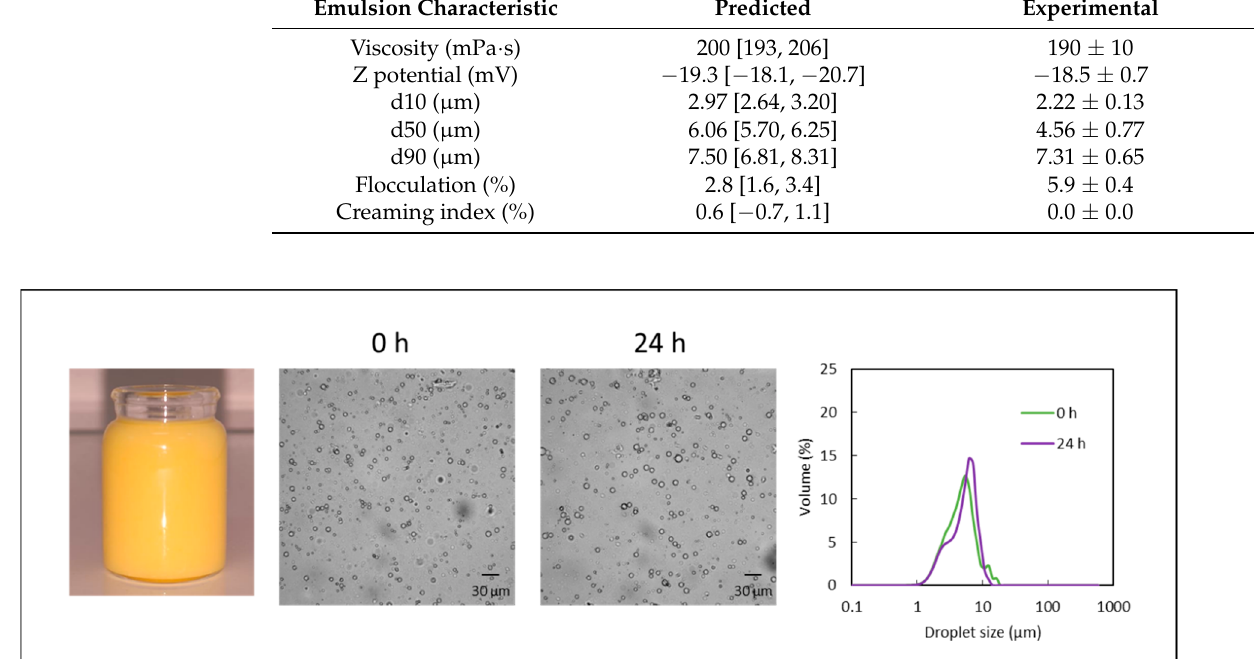
Figure 6. Photograph, micrographs, and droplet size distribution obtained for the optimum emul- sion immediately after its preparation (0 h) and after 24